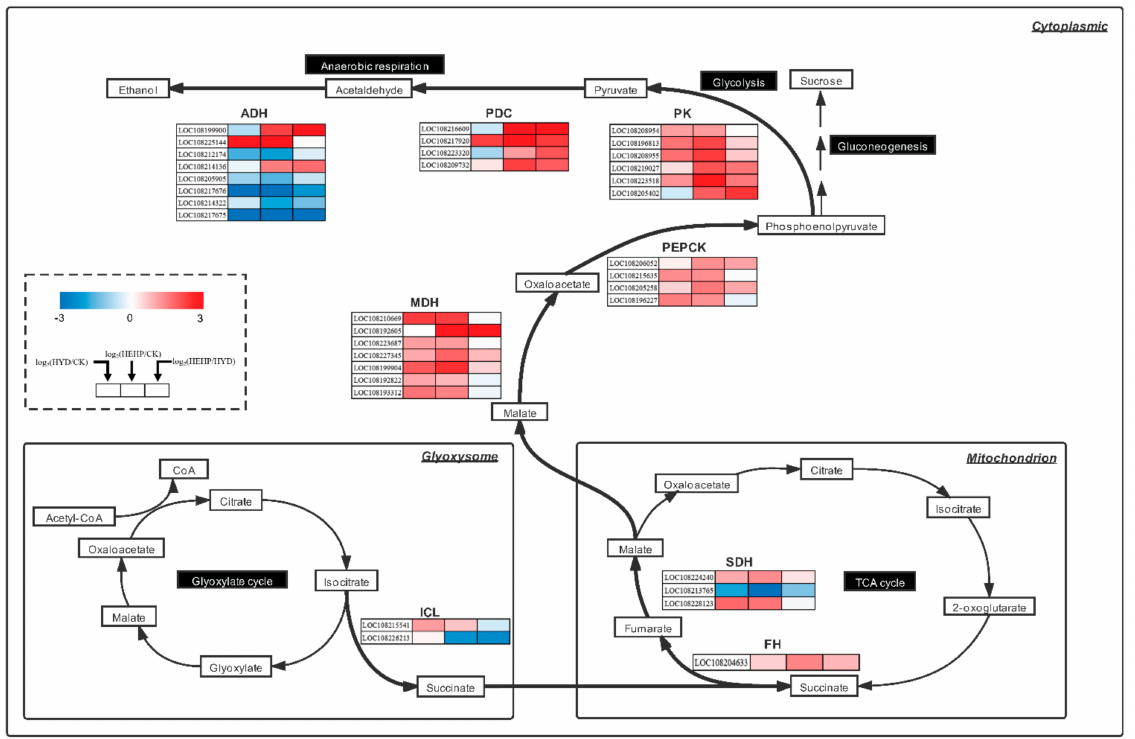
Figure 8. DEGs among CK, HYD and HEHP involved in the glyoxylate cycle and respiratory metabolism. ICL, isocitrate lyase; FH, fumarate hydratase; SDH, succinate dehydrogenase; MDH, NAD-malate dehydrogenase; PEPCK, phospho- enolpyruvate carboxykinase; PK, pyruvate kinase; PDC, pyruvate decarboxylase; ADH, alcohol